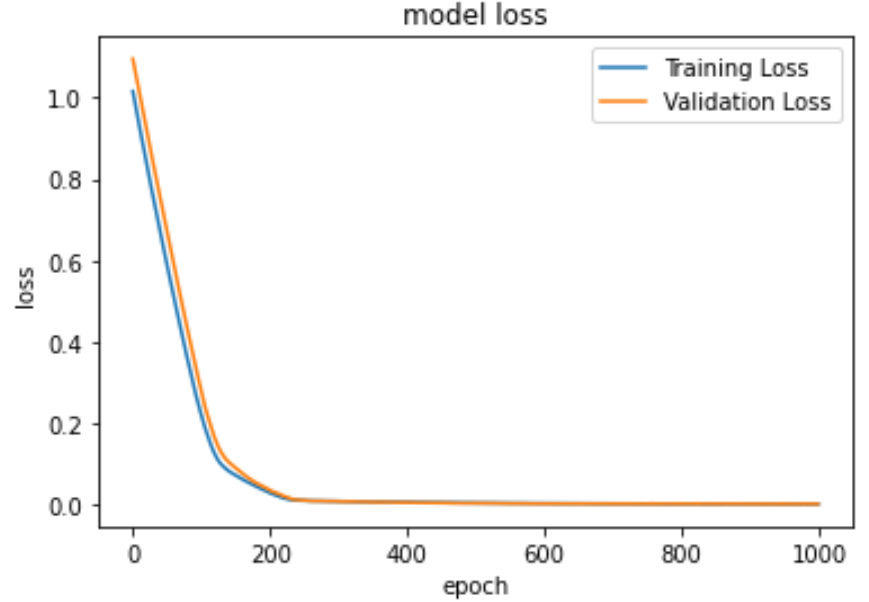
Figure 3. training and validation loss for ANN model. Figure 3. Training and validation loss for ANN